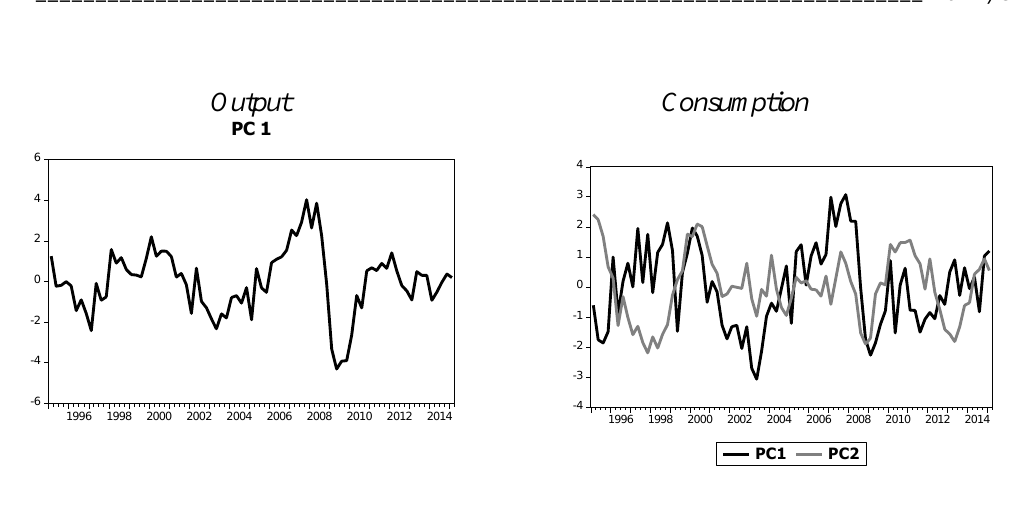
Fig. 2. Nordic output and consumption common cycles.